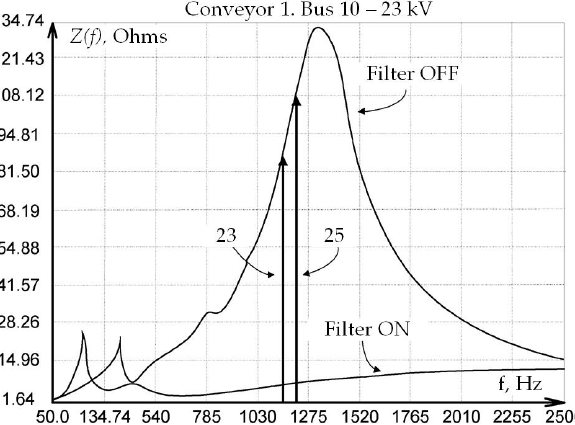
Figure 19. The frequency response of the Los Pelambres mine grid relative to Bus 10.